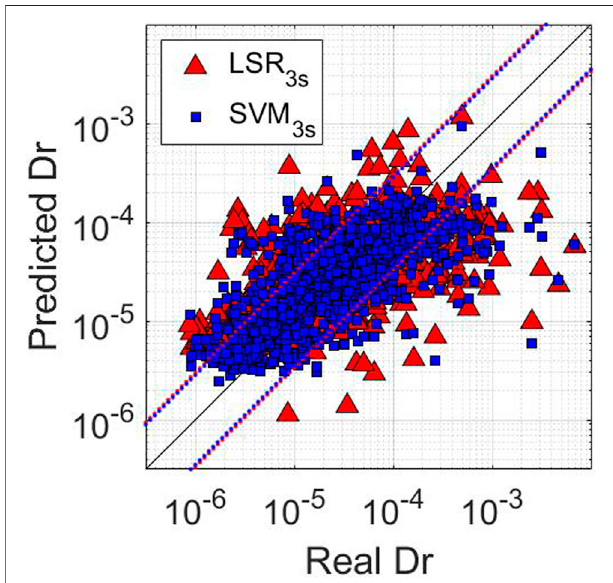
FIGURE 4 | Predicted Dr. vs. Real Dr. of the test set for the Japanese datasetfor3swindows.RedtrianglesrefertothepredictionswithLSR 3s .Blue squares refer to the predictions of the SVM 3s model. The black line Real Dr. (cid:1) Predicted Dr. reference line. The dotted lines represent ± σ train con fi dence level for LSR (red) and ML (blue) models.